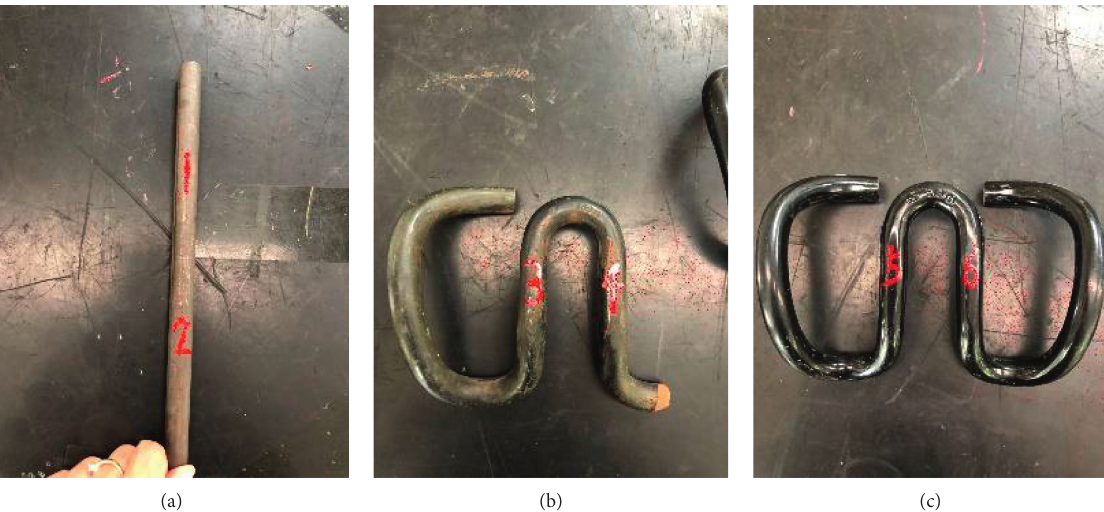
Figure 2: Material specimen of an ω -shaped fastening clip at three different stages: (a) virgin state in the bar form; (b) damaged state after a long service life; (c) newly formed state.